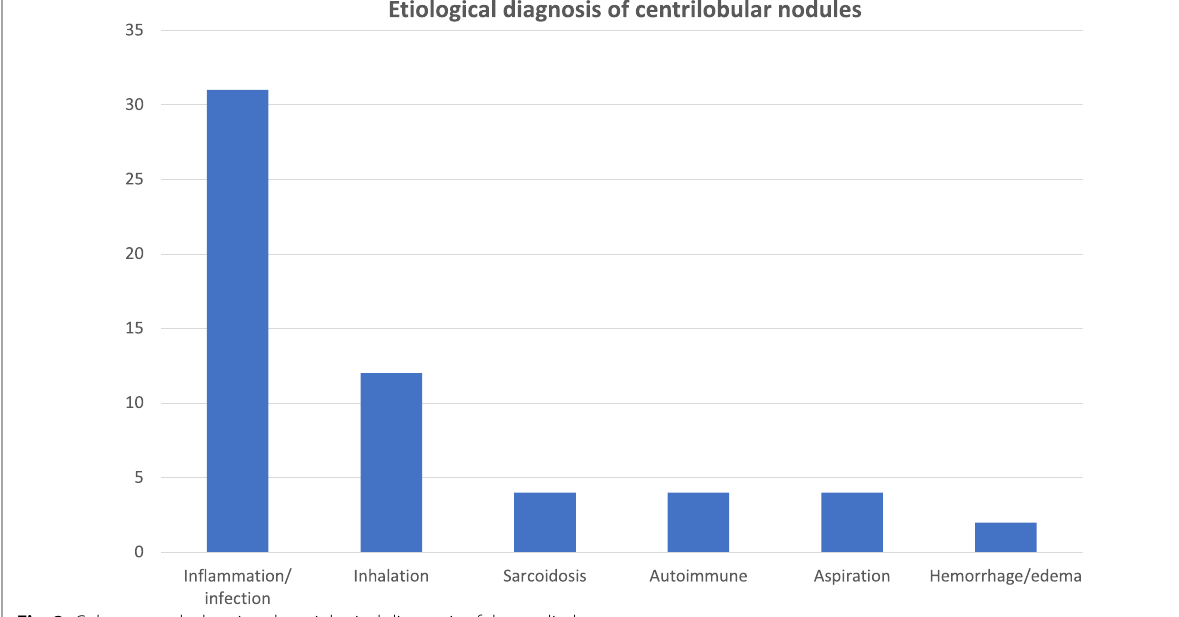
Fig. 2 Column graph showing the etiological diagnosis of the studied cases